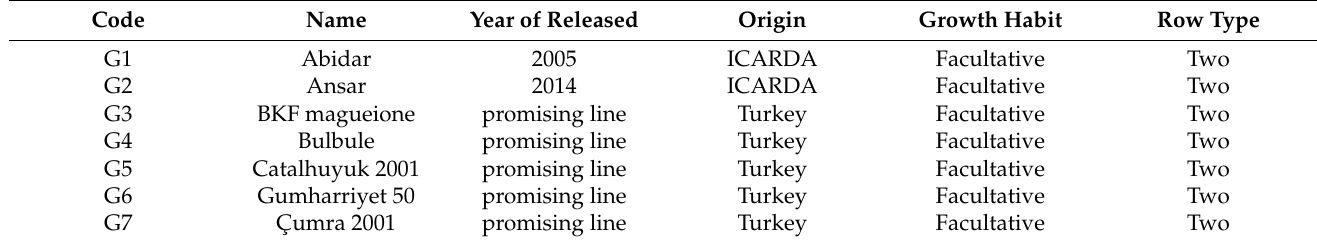
Table 1. The code, name, type and origin of winter barley genotypes in the